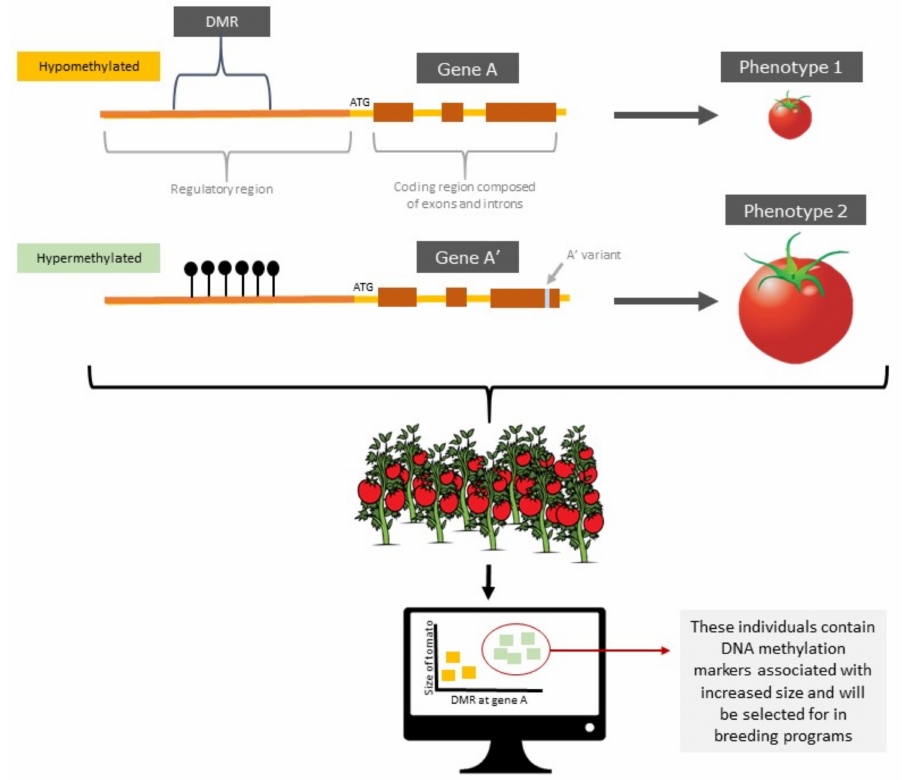
Figure 2. Marker-assisted selection of tomatoes with increased size using epi-markers detecting a differentially methylation region. In the example, the marker would be a patch of methylation that exists in the regulatory sequence of the gene. The hypermethylated form is associated with a gene variant that influences the desired